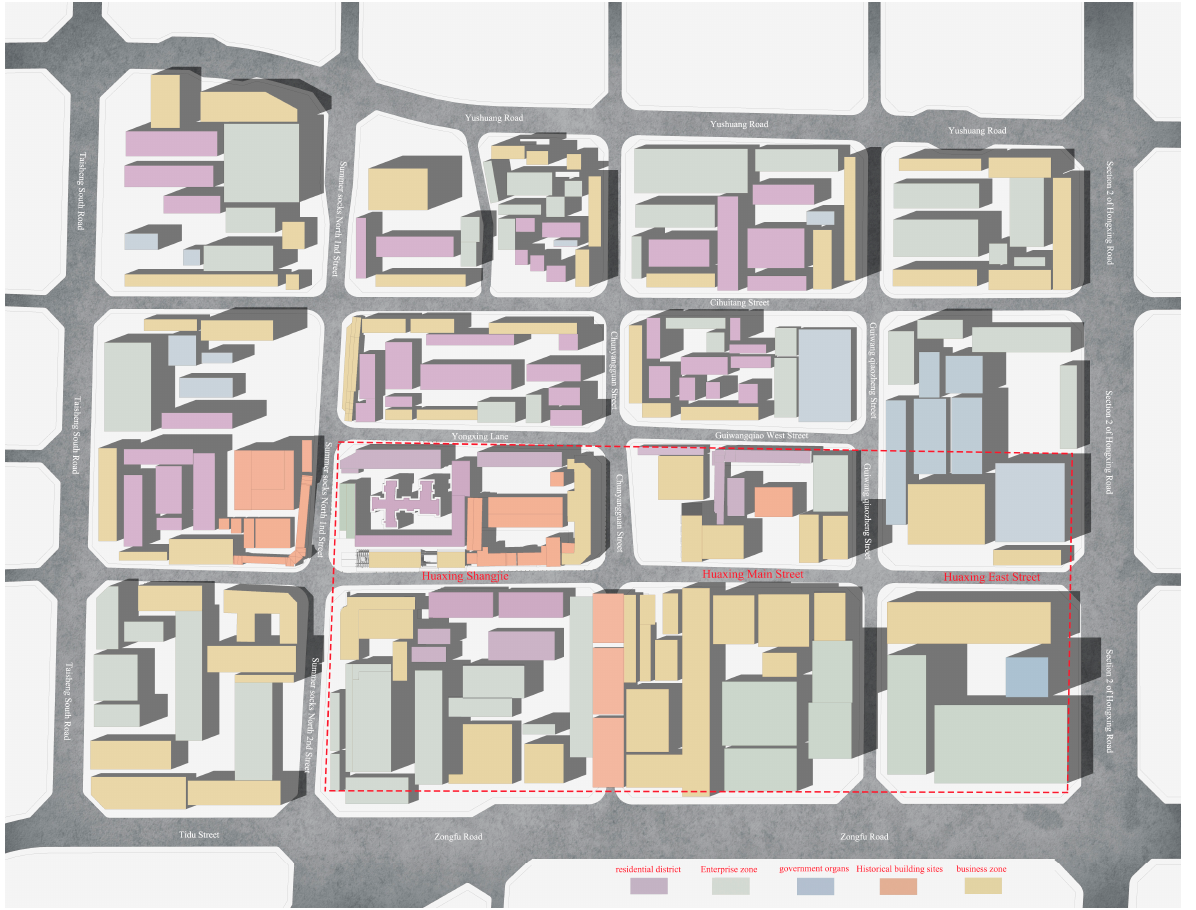
Figure 5. Format Distribution Diagram of Huaxing